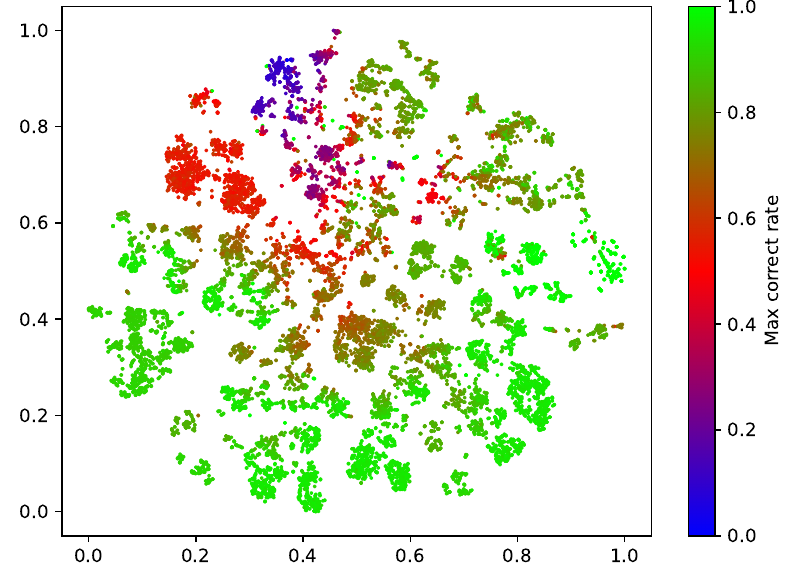
Figure 14. Clustering of open DNS resolvers in